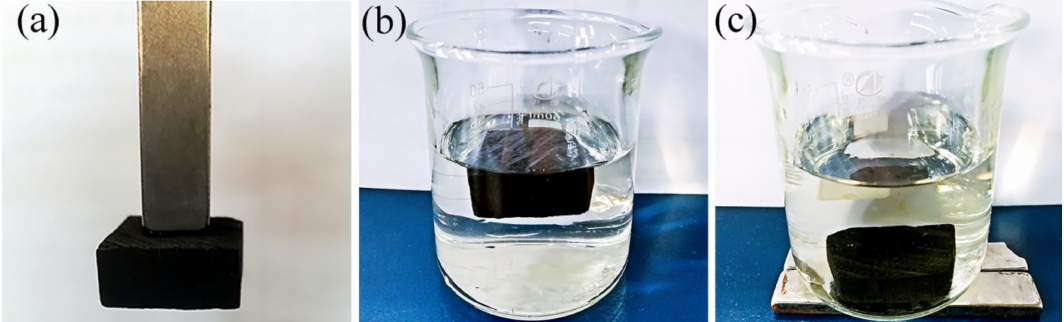
Figure 8. Digital images of the modified wood with an excellent magnetic property. ( a ) Magnetic wood can be firmly attracted by permanent magnet. ( b ) The specimen floating on the surface of the water. ( c ) The specimen can be attracted to the bottom of the cup by an external